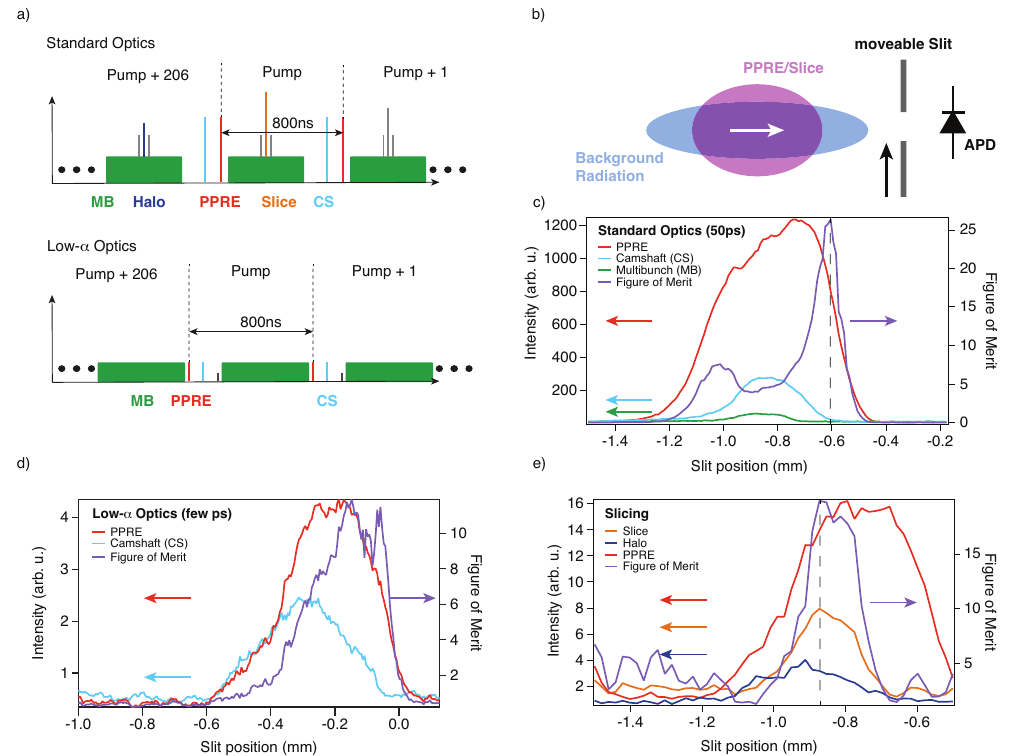
Figure 1. Extraction of sub-bunch patterns at BESSY II with different pulse lengths and repetition rates: ( a ) Sketch of the two fill patterns of BESSY II in the Surface Dynamics main chamber using the standard optics (50 ps FWHM) and low- α optics (few ps FWHM) of the storage ring. Multibunch (MB) in green, PPRE Bunch in red, fs-Slice Bunch in orange, Camshaft bunch (CS) in light blue, Slicing halo Background in dark blue (grey bunches are unused sliced bunches or the low current bunch on low- α operation). ( b ) Spatial filtering of sub-patterns in the spectral plane of the UE56/1-PGM beamline (the white arrow marks the direction of beam propagation). ( c ) Picosecond (50 ps FWHM) bunch extraction with 1.25 MHz repetition rate in PPRE operation (standard optics). ( d ) Picosecond (few ps FWHM) bunch extraction with 1.25 MHz repetition rate in PPRE operation (low- α optics). ( e ) Femtosecond (120 fs FWHM) bunch extraction with 6 kHz repetition rate in time slicing